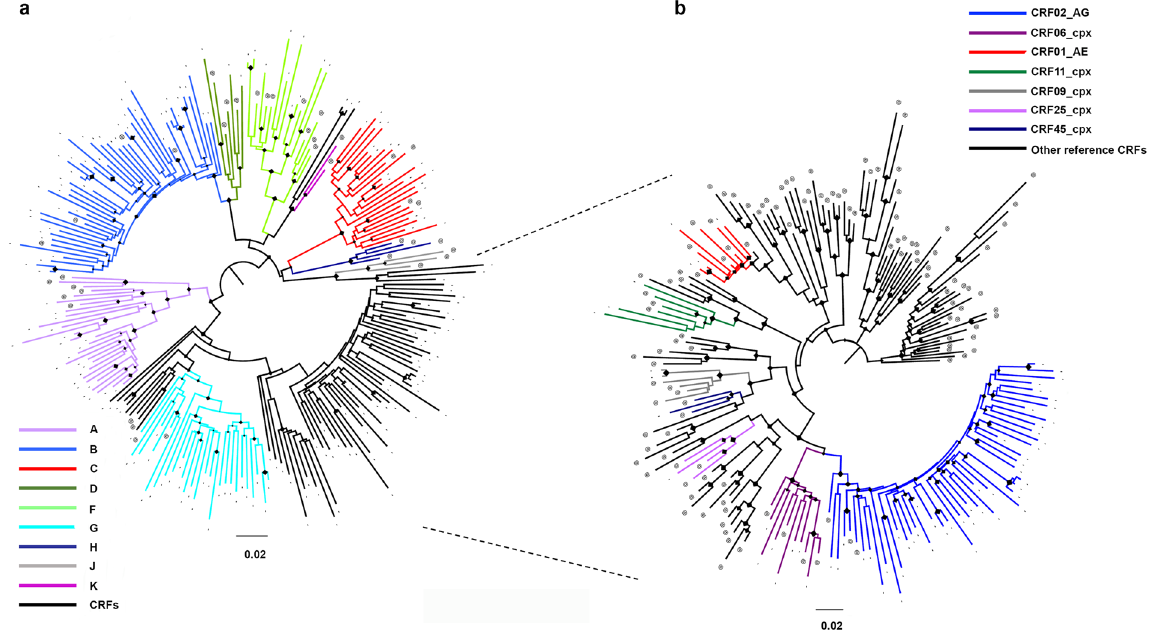
Figure 1. ML phylogenetic tree inferred for HIV-1 genetic forms from 192 HIV-1-infected immigrants. Panel a: ML tree including all the 192 HIV-1 sequences plus pure HIV subtype reference sequences. Panel b: zoom of the ML tree including CRF sequences from our study and CRF reference sequences. “Other CRF reference sequences” are those reference sequences that do not cluster with our sequences. The different subtypes and CRFs are shown in colour, according to the legends present on the top left for panel a, and top right for panel b, respectively. Sequences from our study are indicated with “-“. Reference sequences are indicated with “@”.The diamond ( ♦ ) located in the nodes represents significant statistical support for the clade subtending that branch (bootstrap support > 70%). The scale bar indicates 0.02 nucleotide sequence difference. Frequency of each pure subtype and CRF is shown at the bottom of panel a and b, respectively.